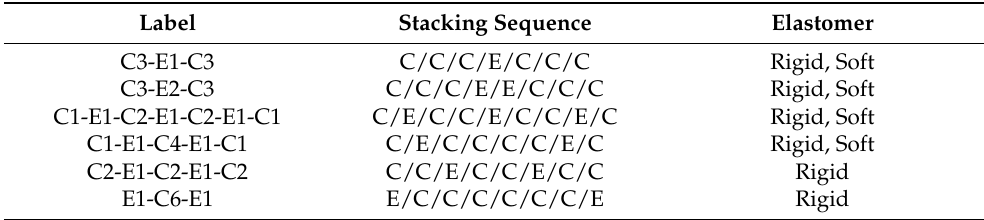
Figure 2. Architectures of the hybrid composite structures (C = CFR ply, E = elastomer layer). Table 1. Stacking sequence of the molded plates.